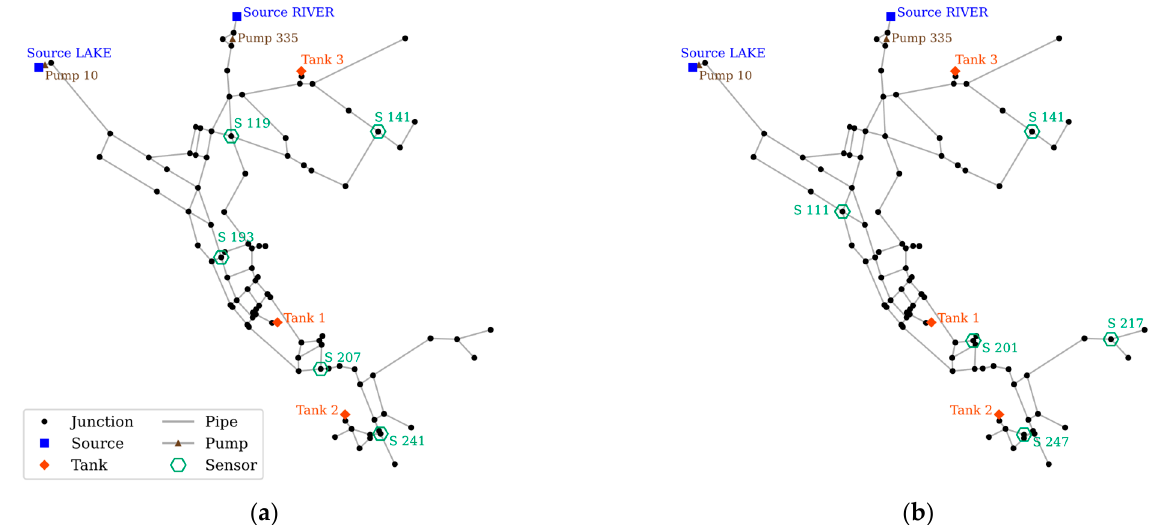
Figure 6. Comparison of five sensor placement between ( a ) TEVA-SPOT and ( b ) SPSO. Table 3. Comparison of objective values between TEVA-SPOT and SPSO. TEVA-SPOT SPSO Improvement Fitness